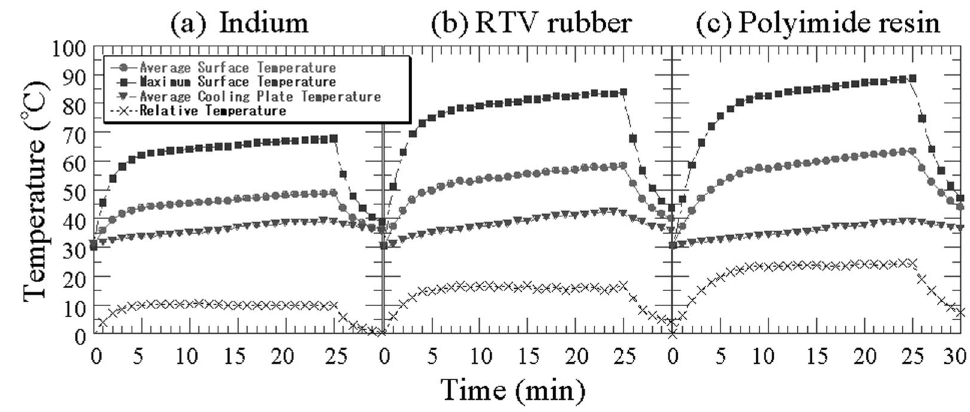
shown.FIG. 9. Time dependence of the maximum (square) and the average (circle) surface temperatures of the core and the average temperature (triangle) of the cooling plate for the case of (a) indium-bonded, (b) RTV-rubber-adhered, and (c) polyimide-resin-adhered cores. Cross marks correspond to the relative temperature explained in this study.